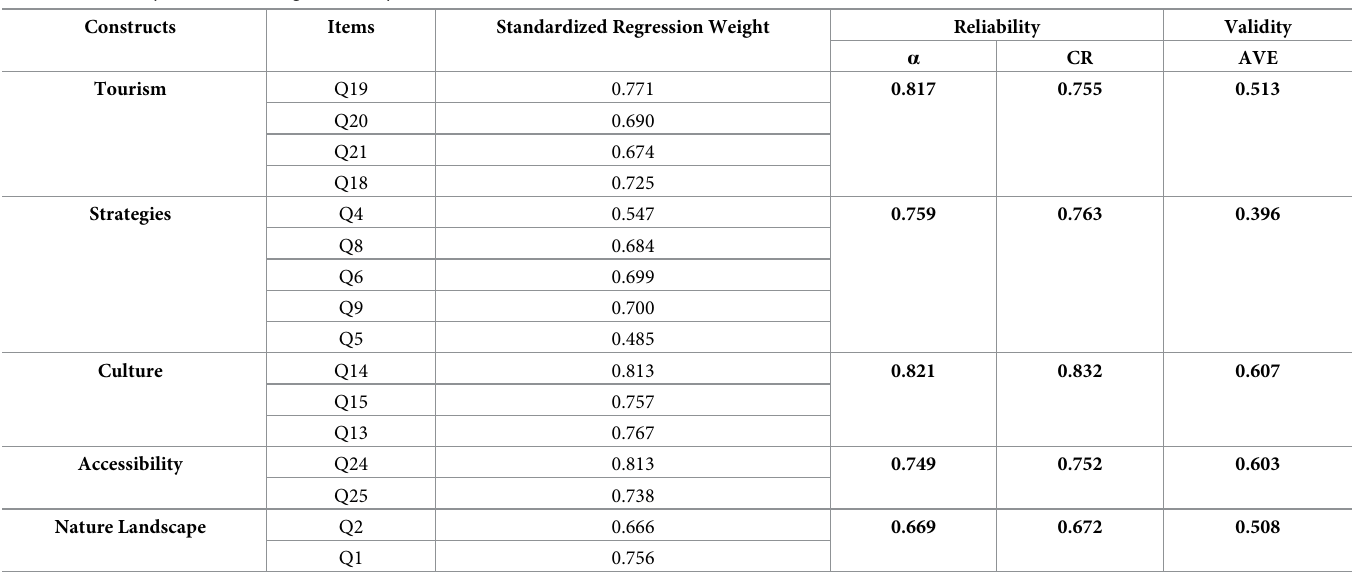
Table 5. Reliability test and convergent validity of the measurement model.